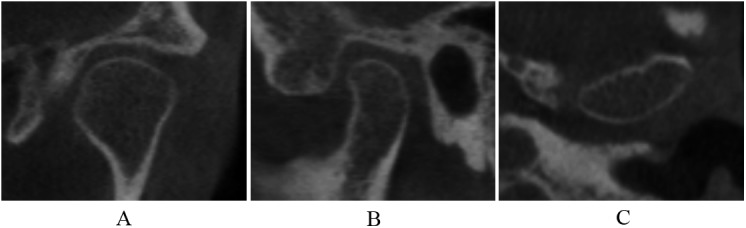
Normal condyle in coronal (A), sagittal (B), and axial (C) images.